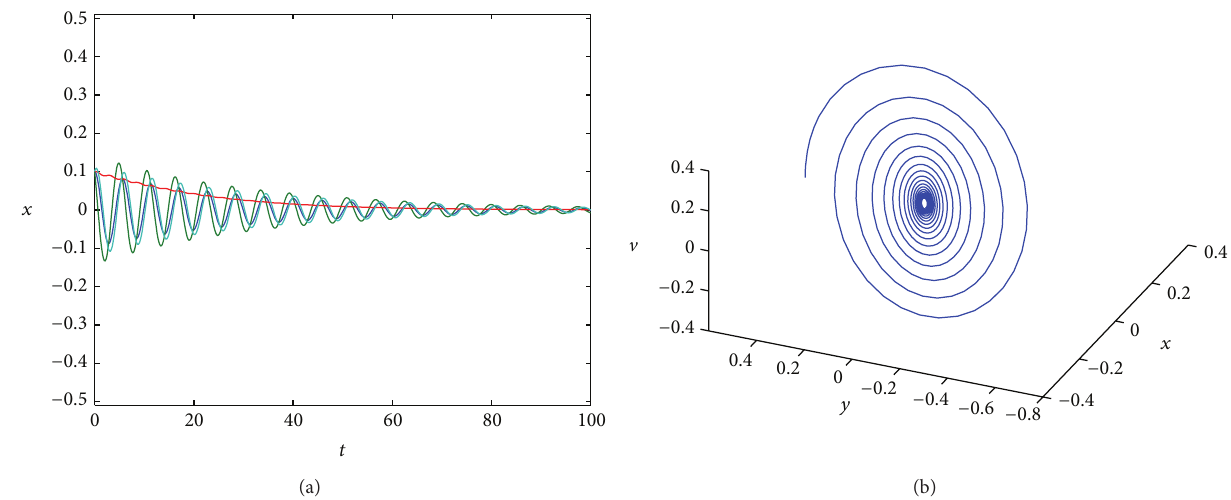
Figure 5: Time history and phase diagram of system (16) with 𝑎 = 1 , 𝑐 = 0.08 , 𝑚 = 0.5 , 𝑘 1 = 0.8 , 𝑘 2 = 0.5 , and 𝑏 = −0.2 .